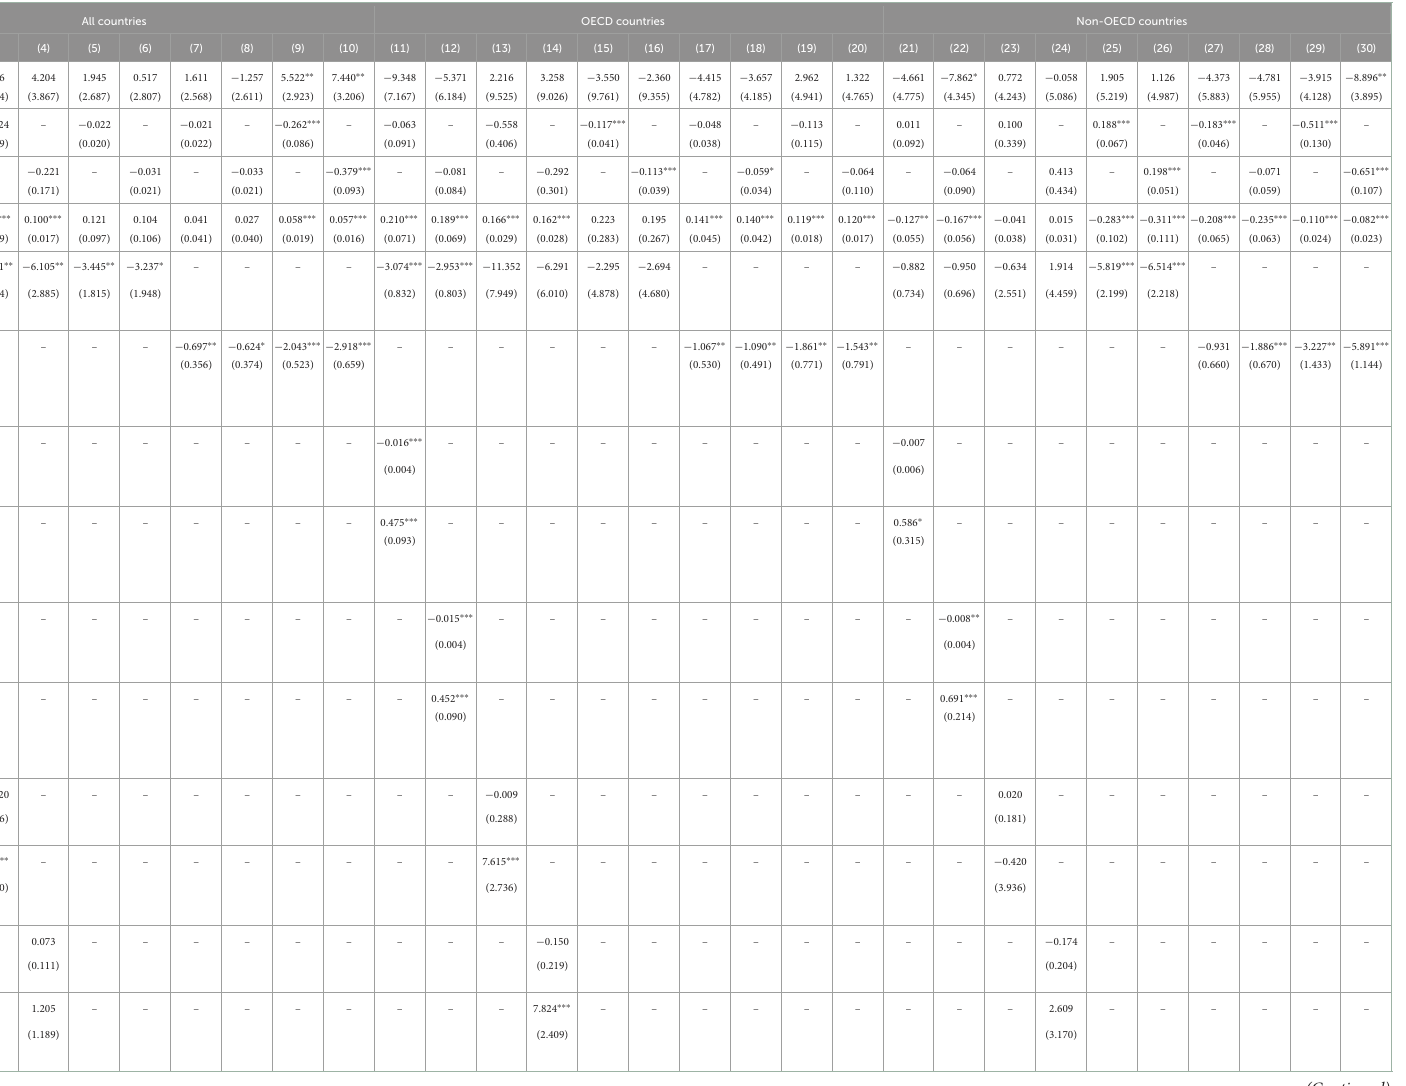
TABLE 4 Dual interactive decentralization and